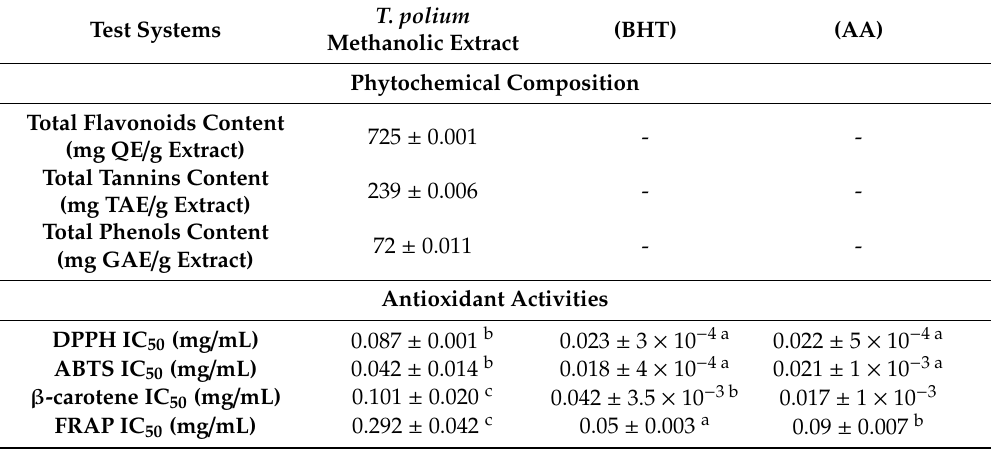
Table 4. Antioxidant activities of T. polium + methanolic extract as compared to ascorbic acid and